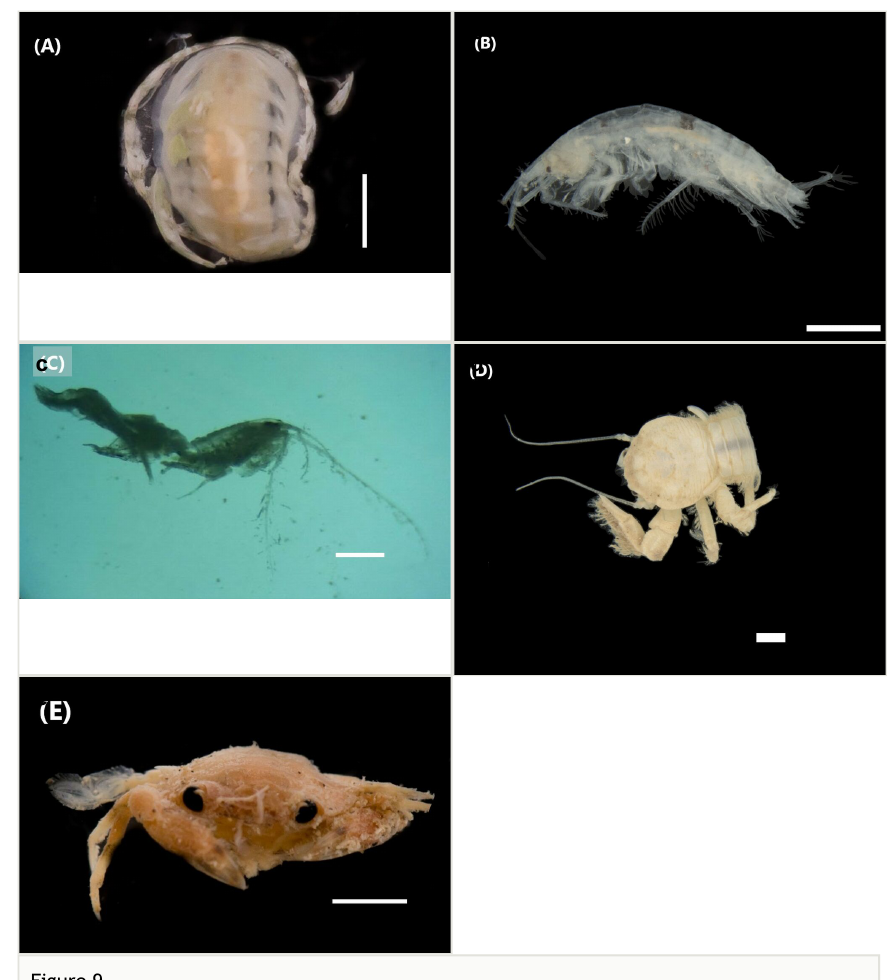
Figure 9. Molluscs and arthropods crustaceans identified on the beaches from Paraíba coast. Scale bars = 1 mm (A, B and D), 2 mm (C), 5 mm (E). Photos: (A and E) by Freitas, P.; (B and D) by Prata, J.; (C) by Costa,